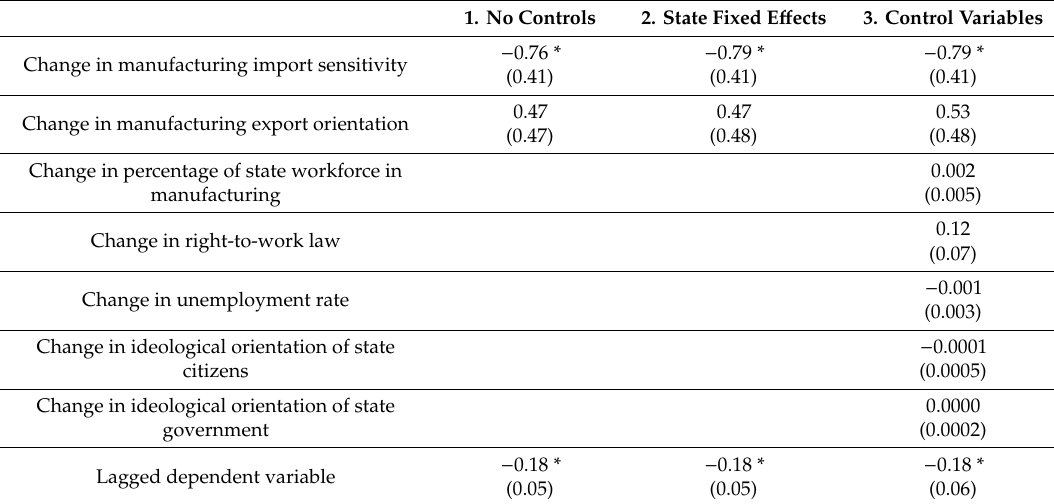
Table 4. Di ff erenced OLS Models of the Union Density in U.S. States, 1964–2001. 1. No